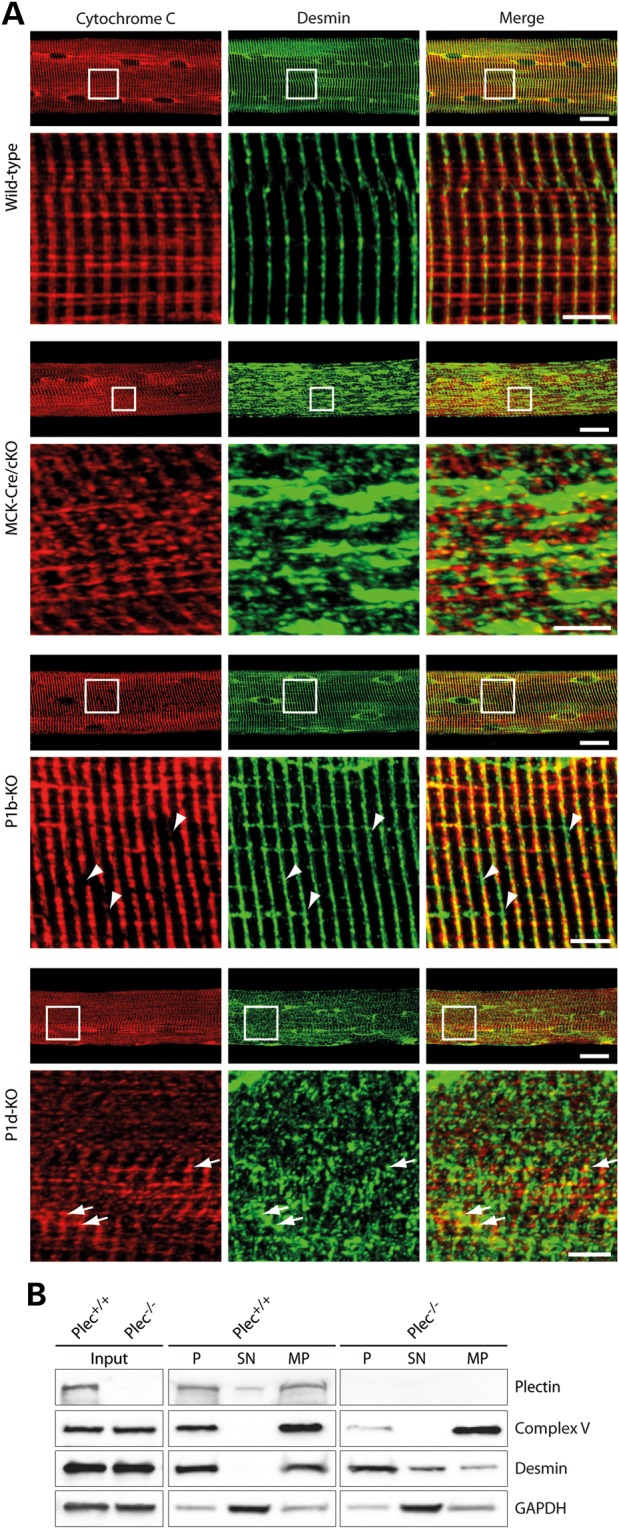
Plectin isoform-dependent alterations in mitochondrial and desmin network architecture. (A) Teased EDL muscle fibers derived from wild-type, MCK-Cre/cKO, P1b-KO or P1d-KO mice were co-immunolabeled using antibodies to cytochrome c and desmin. Lower panels are magnifications of boxed areas indicated in upper panels. Note collapsed desmin IF networks and randomly oriented mitochondria in MCK-Cre/cKO and P1d-KO fibers. In P1d-KO fibers, contrary to MCK-Cre/cKO fibers, mitochondria were often still in close vicinity to desmin network remnants (arrows). Moreover, note Z-disks regions devoid of mitochondria in P1b-KO fibers (arrowheads). Scale bars: 20 µm (upper panels) and 5 µm (lower panels). (B) Immunoblotting of total cell lysates (input) and subcellular fractions derived from Plec+/+ and Plec−/− myoblasts using antibodies to plectin, Complex V, and desmin. GAPDH was used as loading control. P, pellet (containing nuclei and insoluble cytoskeletal proteins); SN, pooled supernatant fractions of cell homogenates (cytosol) after differential centrifugation; MP, crude mitochondrial pellet. Note that Complex V, the mitochondrial marker protein, could hardly be detected in the insoluble (P) fraction in the absence of plectin, whereas desmin, the cytoskeletal marker protein, was increased in the cytosolic (SN) fraction. One out of three experiments is shown.